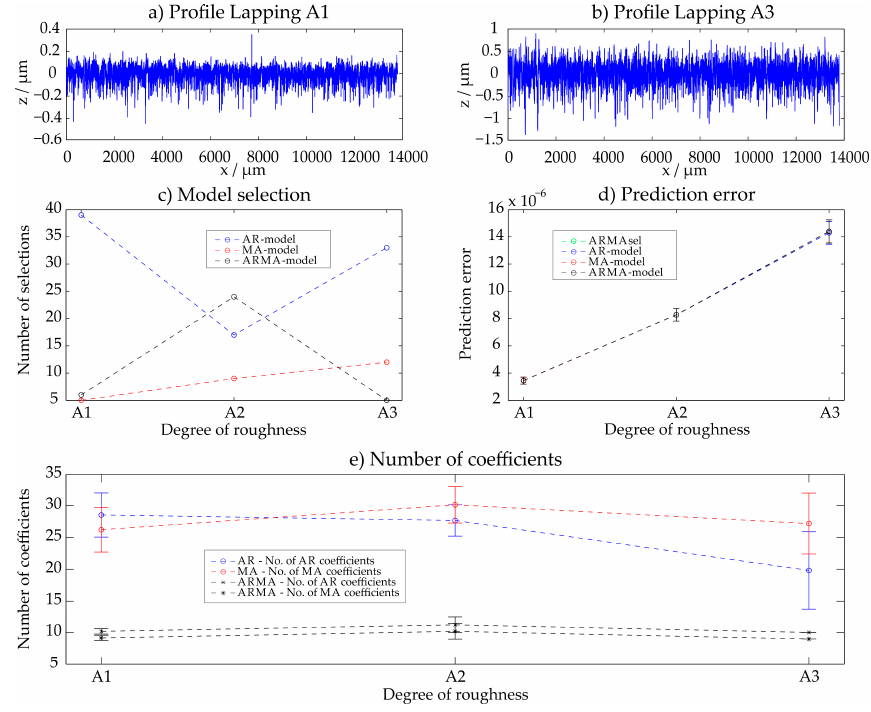
Figure 3. Lapping—results with the ARMAsel-algorithm.